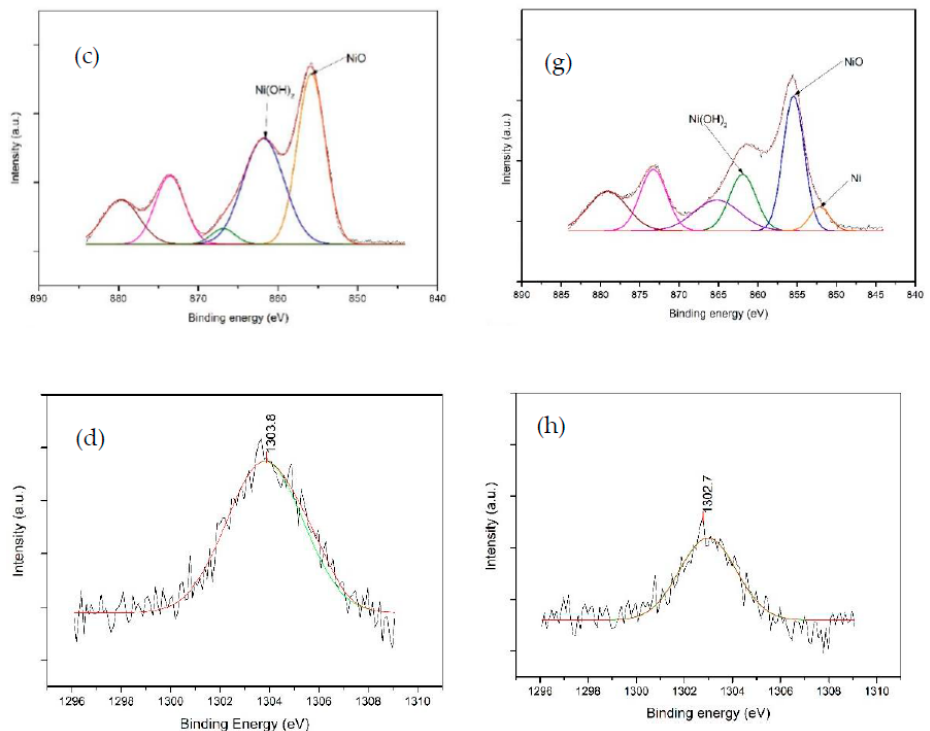
Figure 13. XPS patterns of fresh Ni-Mg-Al catalysts ( a ) 20 wt% Ni, ( b ) 40 wt% Ni, ( c ) 60 wt% Ni, ( d ) 60wt% Mg and spent catalysts ( e ) 20 wt% Ni, ( f ) 40 wt% Ni, and ( g ) 60 wt% Ni, ( h ) 60wt% Mg (* for 20 wt%, Reference [41] was cited.).